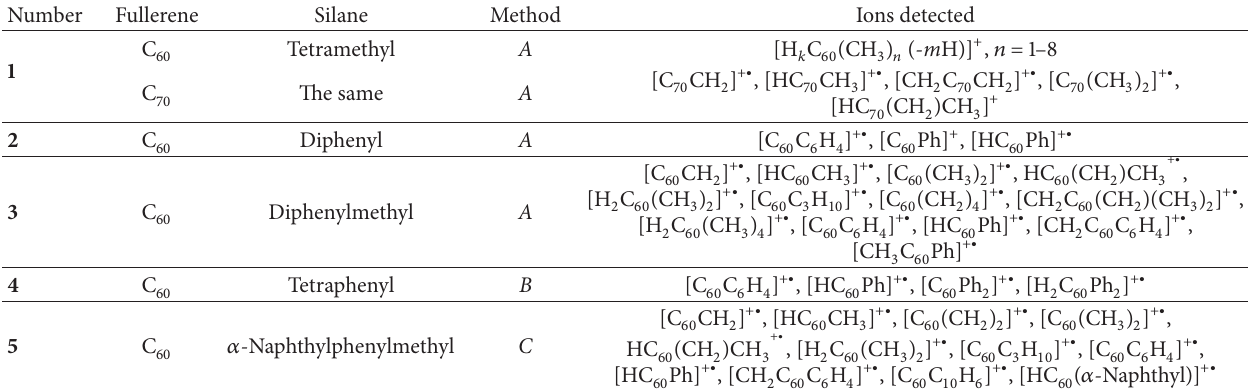
Table 1: Ions of the main products formed in the reactions of fullerenes with organosilanes in the IC of a mass spectrometer under EI.